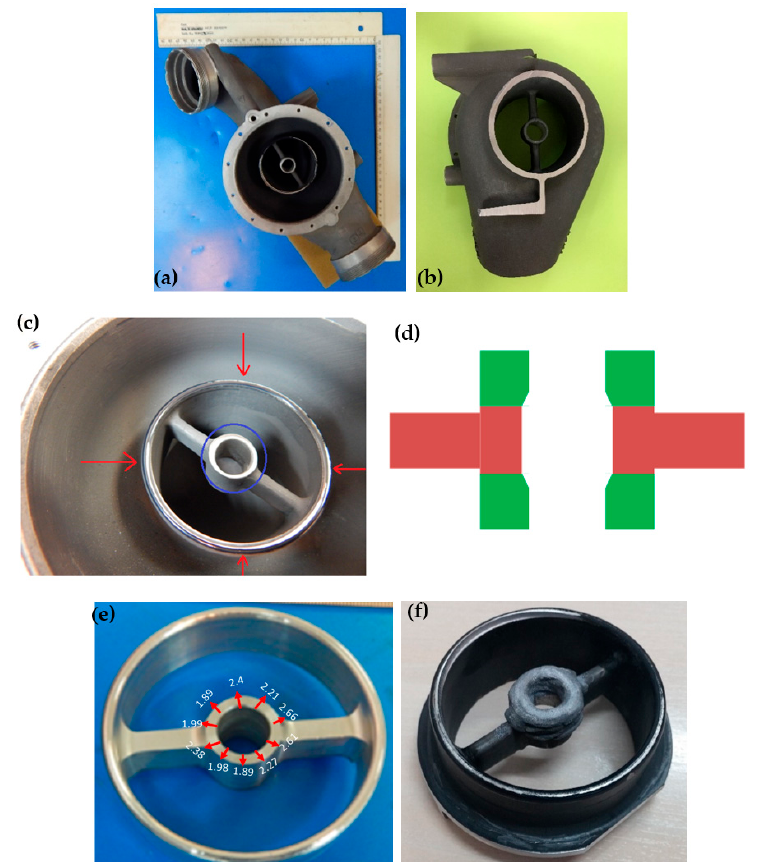
Figure 3. A housing made of cast AA3xx aluminum alloy repaired using LENS and Al 4047 alloy. ( a ) General view, front side. ( b ) Flange back-side opening. This section weighs 1.01 kg. ( c ) Worn area requiring repair. Red arrows mark the border to be repaired according to the model. The blue circle marks the borehole to be rebuilt. ( d ) A side view sketch of the area that was machined prior to repair is colored green. ( e ) Varying wall thickness of the repair housing after grinding, prior to LENS deposition. ( f ) The part after LENS repair.